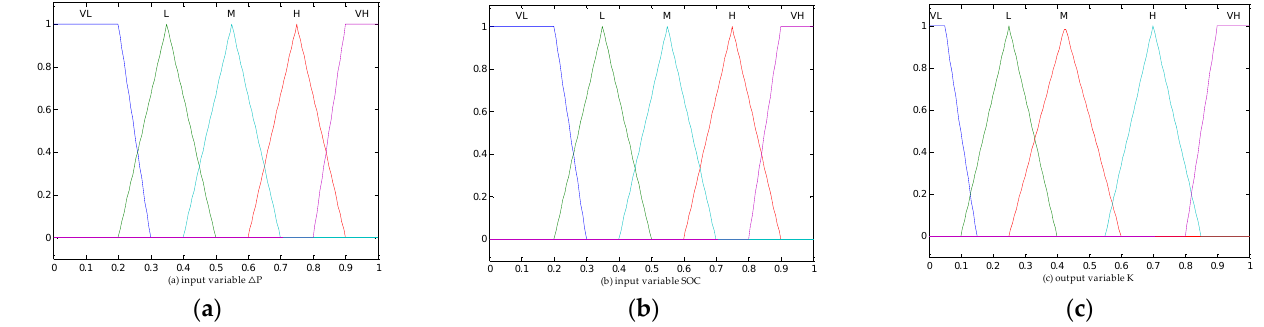
Figure 4. Membership function. ( a ) Input variable ∆ P ; ( b ) input variable SOC ; ( c ) output variable K . Formulation of Fuzzy